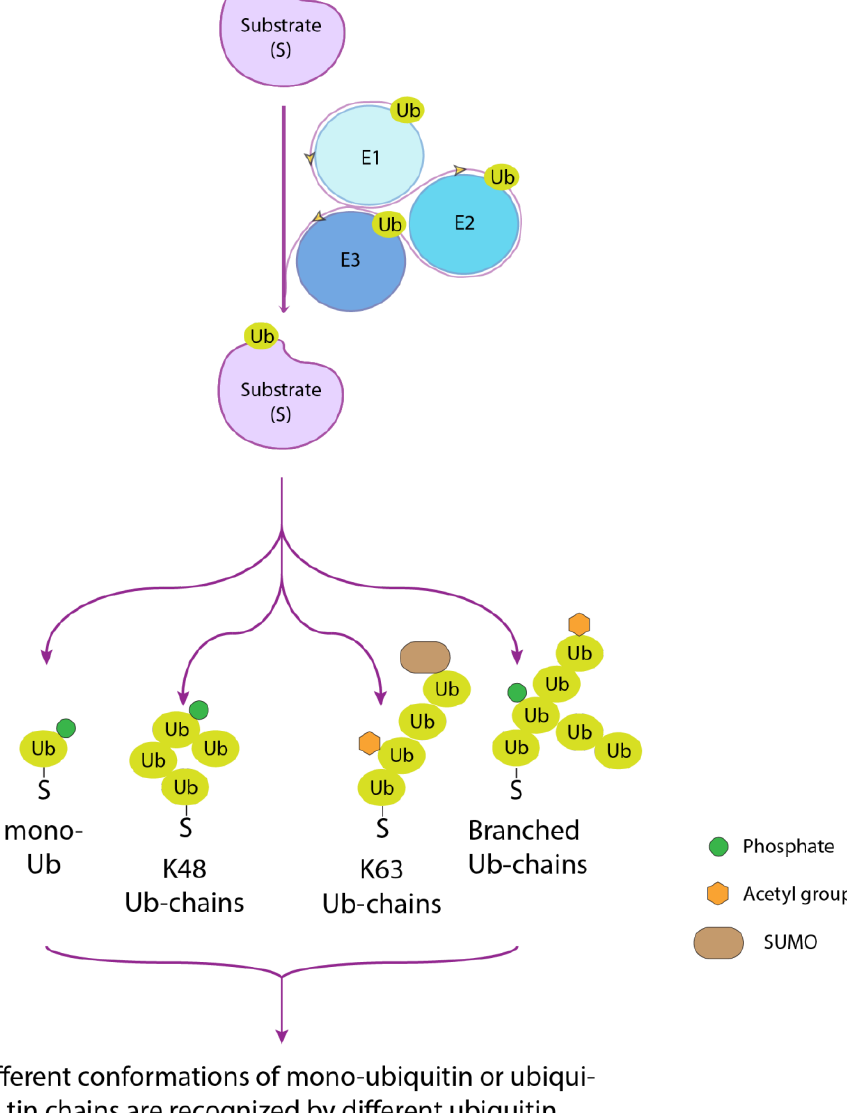
Figure 1. An enzymatic cascade involving an activating enzyme (E1), a conjugating enzyme (E2) and a ligase (E3) carries out protein substrate ubiquitination. The ubiquitin moiety conjugated to a substrate can be targeted for additional ubiquitination cycles, potentially involving all seven ubiquitin lysines (K6, K11, K27, K29, K33, K48 and K63) and the first methionine (M1). Di ff erent chain topologies are generated according to the specific branching. The conjugated ubiquitin moieties can be further modified by di ff erent post-translational modifications, such as phosphorylation, acetylation and sumoylation. Di ff erent polyubiquitin chains, as well as the presence of other post-translational modifications, determine di ff erences in the conformations of the protein chains and therefore have specific e ff ects on the protein to which they are attached. The association of protein post-translational modifications (PTMs) shown on the diagram is to be considered only as an example. To date, 25 different UBD families have been identified, many of which have spread in different proteins. In a limited number of cases, ubiquitin-binding domains represented by a unique member can be found [16,29,30]. Based on their structural fold, UBDs are categorized into three main groups. The largest group includes UBDs having an α-helical folding. Belong to this group are UBA, UIM, GAT (GGA and TOM), VHS, CUE (coupling ubiquitin conjugation to ER degradation), UBM (ubiquitin-binding motif), UBAN, UBW (ubiquitin-binding winged-helix domain), MyUb (myosin VI